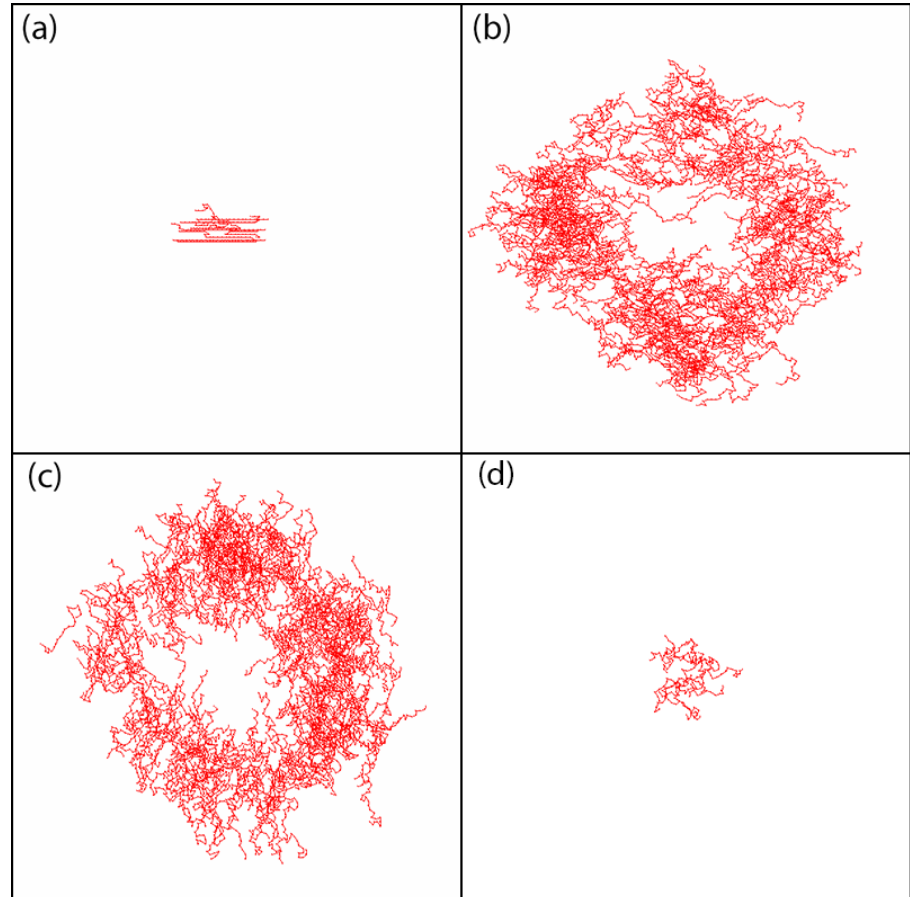
Figure 6. Configurations of chains after 6000 MCS, I 0 = 1: FPM without thermal movements, Θ = 0 ◦ ( S = 0.81, 10 chains are shown) ( a ); FPM with Θ = 0 ◦ ( S = 0.15, 300 chains are shown) ( b ); FPM with Θ = 90 ◦ ( S = 0.15, 300 chains are shown) ( c ); and PI model ( S = 0.002, 10 chains are shown) ( d ). Only a 300 × 300 part of the lattice is